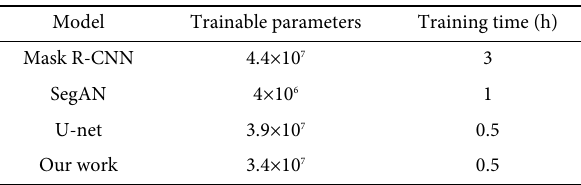
Table 2 Complexity of models.